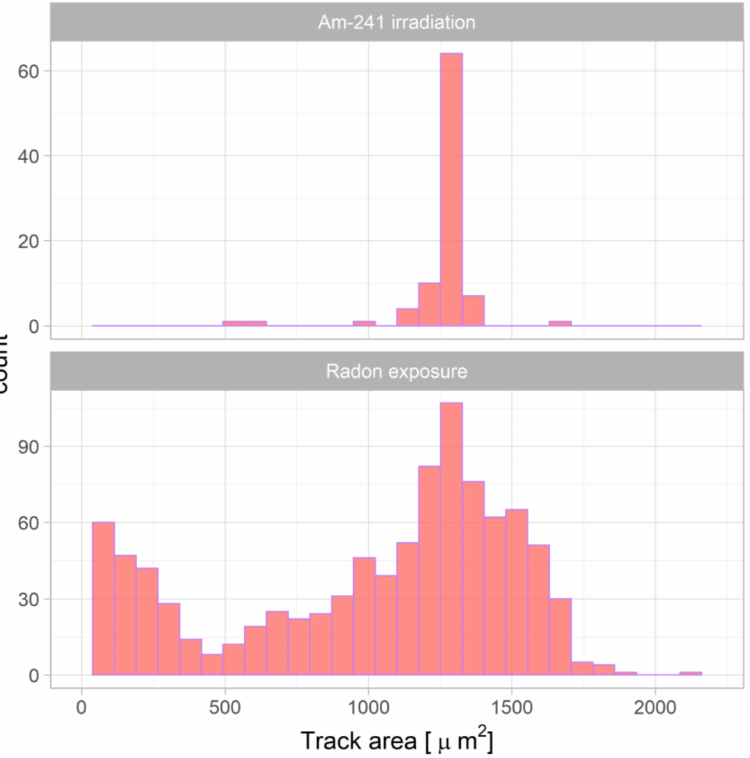
Figure 8. Spectra of track areas obtained in Experiment 2 for 241 Am irradiation (upper) and radon exposure